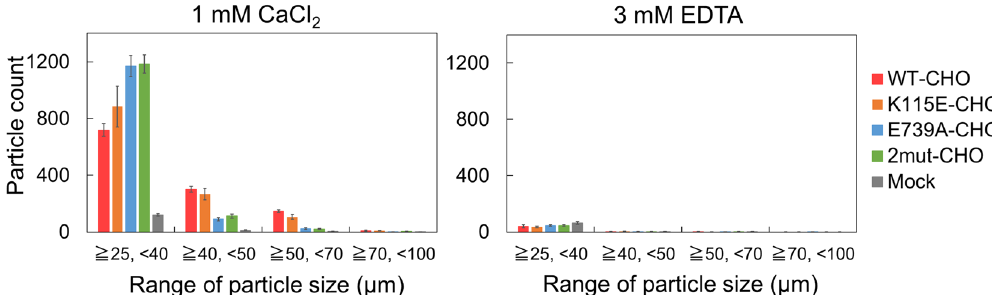
Figure 1. Size distribution of cell aggregates determined via micro-flow imaging (MFI). The Y axis indicates the number of cell aggregates detected during the measurement. Particles that are 25 μm or larger were regarded as cell aggregates. LI-cadherin-expressing cells formed cell aggregates when 3 mM EDTA was not added. E739A- CHO and 2mut-CHO tended to form small cell aggregates. Means and standard errors are